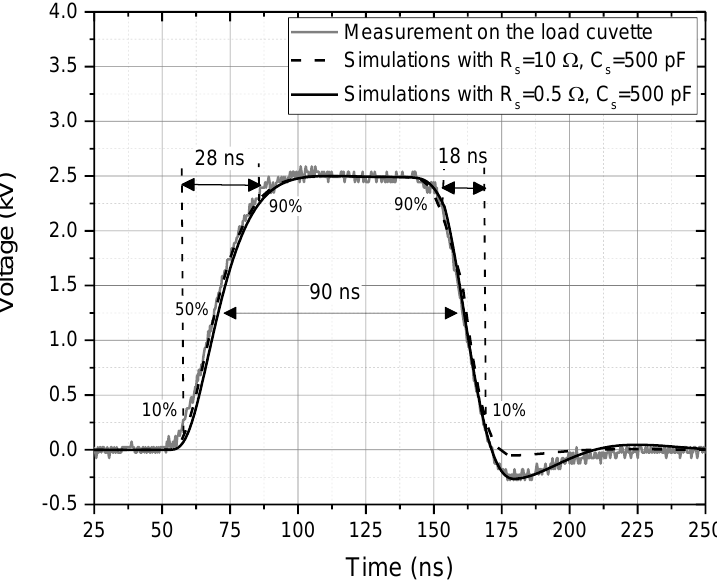
Figure 4. The comparison of simulation and experimental results of a single electrical pulse waveform generated by the PEF generator.